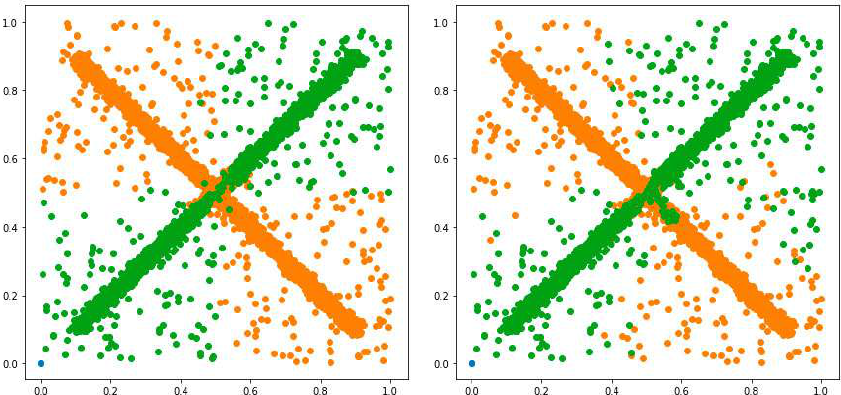
Figure 3. Example of instances from the second dataset, classified by HPFuzzNDA (the left graph) and PFuzzND (the right graph) algorithms. Here, the best achieved results by both algorithms are presented. However, it is clear that class extension caused by the presence of unlabelled data was not detected correctly by PFuzzND.